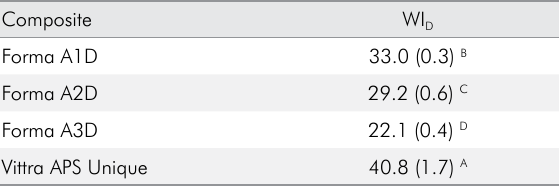
Table 1. Means (and standard deviations) of whiteness indices evaluated in simple specimens.